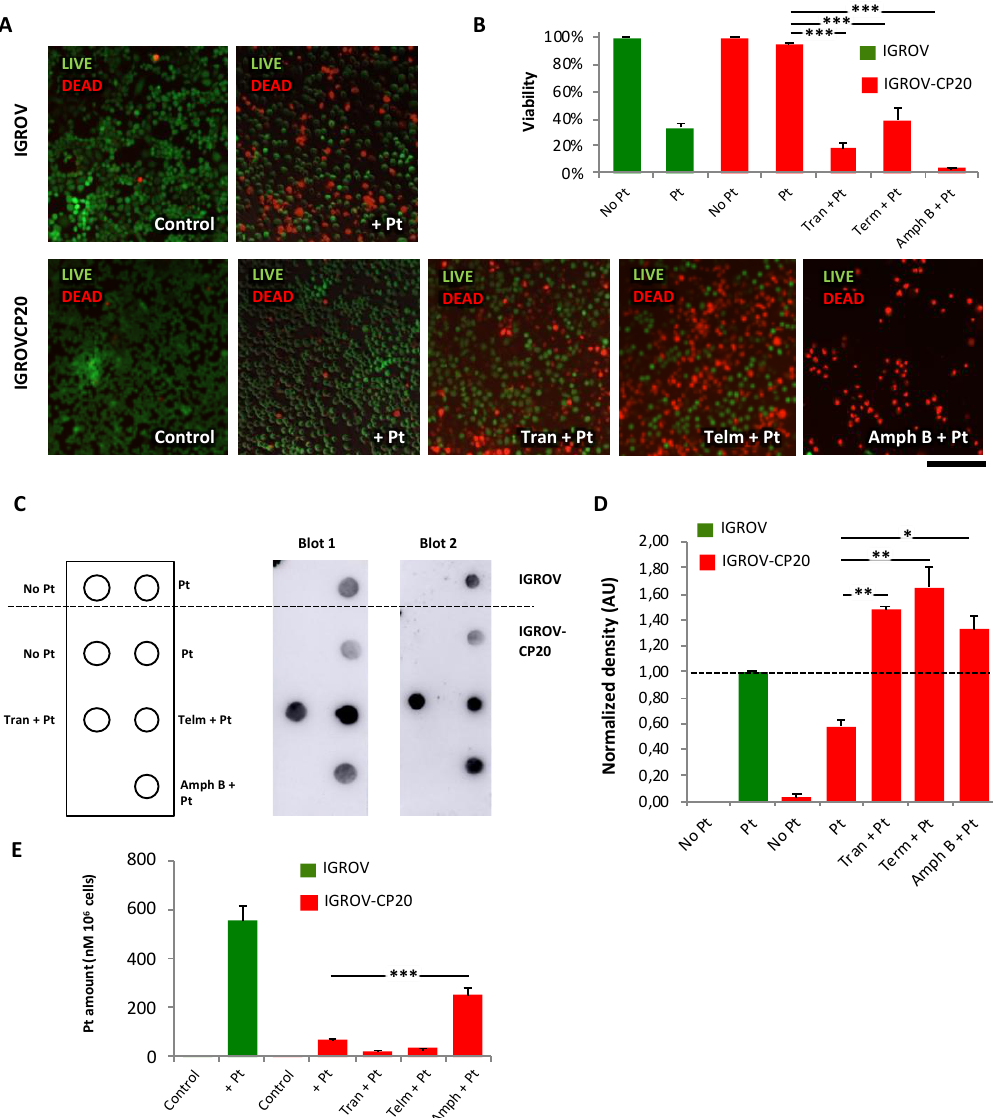
Figure 3. FDA-approved drug hits promote cisplatin toxicity and stimulate DNA adduct formation in resistant IGROV-CP20 tumor cells. ( A ) Representative images of live / dead assay (see Section 4) showing the effect of 50 µM cisplatin (Pt) on the cell viability of IGROV or IGROV-CP20 cells, as indicated. Pretreatment with 10 µM Tranilast, Telmisartan, or Amphotericin B for 24 h increased cell death of IGROV-CP20 cells when combined with cisplatin. ( B ) Quantification of experiments shown in panel A reveals a significant decrease in viability of IGROV-CP20 cells treated with a mixture of cisplatin and indicated drugs ( n = 10 fields; *** p < 0.001, ANOVA). ( C ) Pt adducts were evaluated via dot immuno-blot (see Section 4) with DNA samples from IGROV cells (above the dashed line) and IGROV-CP20 cells (below the dashed line), which were spotted as indicated in the membrane map (on the left). Two dot blot images demonstrate that cisplatin (Pt) in association with Tranilast, Telmisartan, or Amphotericin B induces a significant increase in the DNA adduct signal compared to the IGROV-CP20 treated with cisplatin alone ( D ) The graph shows quantification of the DNA adduct signal in dot blot experiments ( n = 10 fields; ** p < 0.01, * p < 0.05, ANOVA). ( E ) Cells were treated as in panel A and prepared for ICP-MS (see Section 4) to evaluate intracellular platinum levels. Only the combination of Amphotericin B with cisplatin led to an increase in the overall platinum levels in the